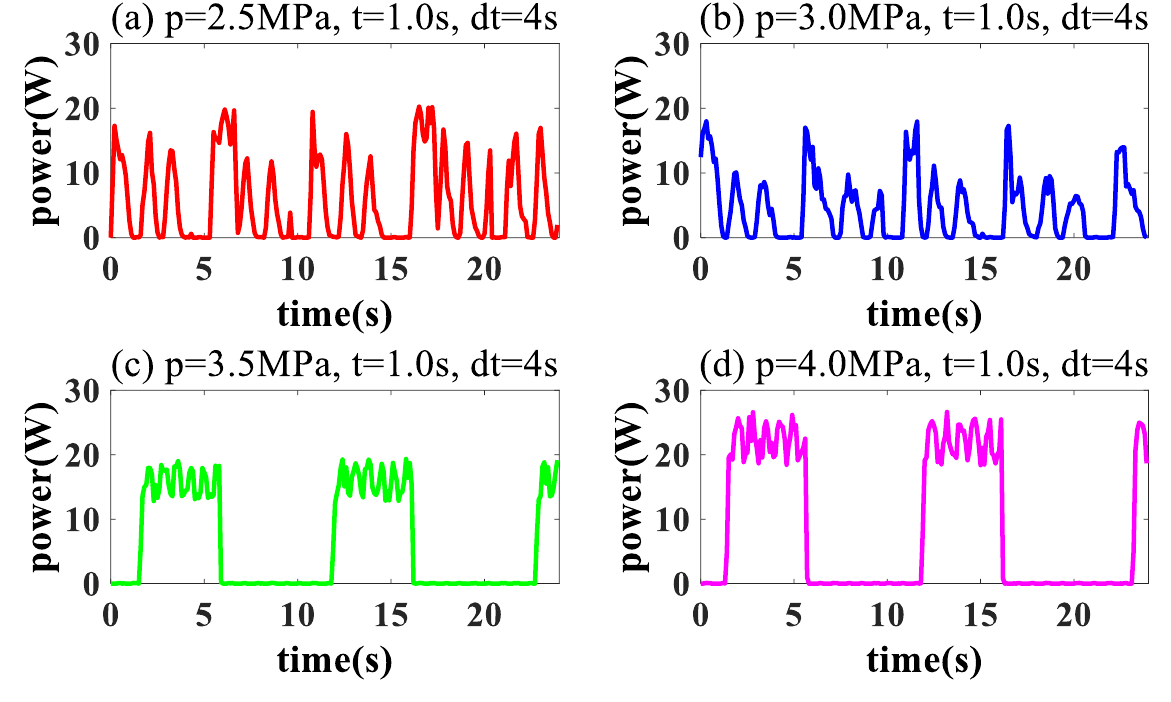
Figure 7. Output power under different trigger pressures.